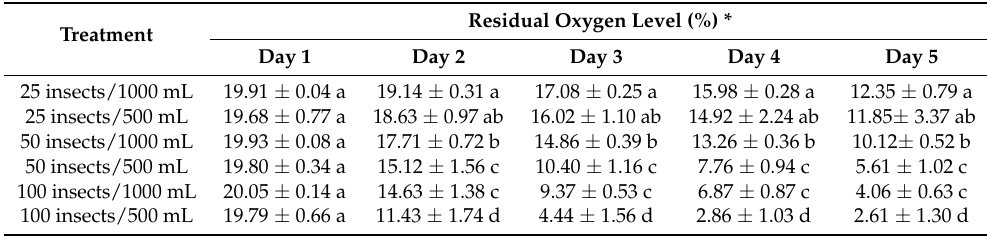
Figure 1. Oxygen level for 25, 50, and 100 Callosobruchus maculatus adults enclosed in hermetically sealed ( a ) 500 mL jars and ( b ) 1000 mL jars during a 15 d hermetic storage period. Table 1. Mean (±SE) residual oxygen level for 25, 50, and 100 adults of Callosobruchus maculatus on days one to five of hermetic storage treatment in 500 mL and 1000 mL jars (n = 396) .